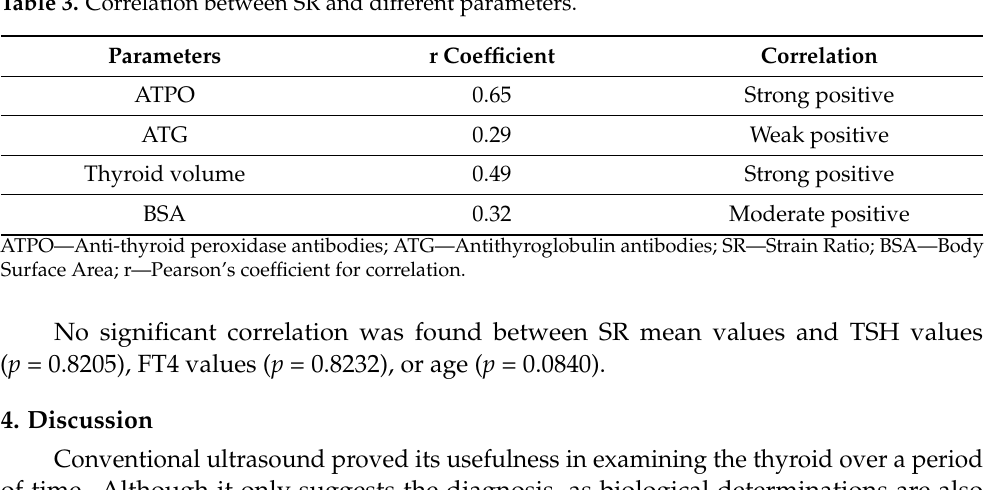
Table 3. Correlation between SR and different